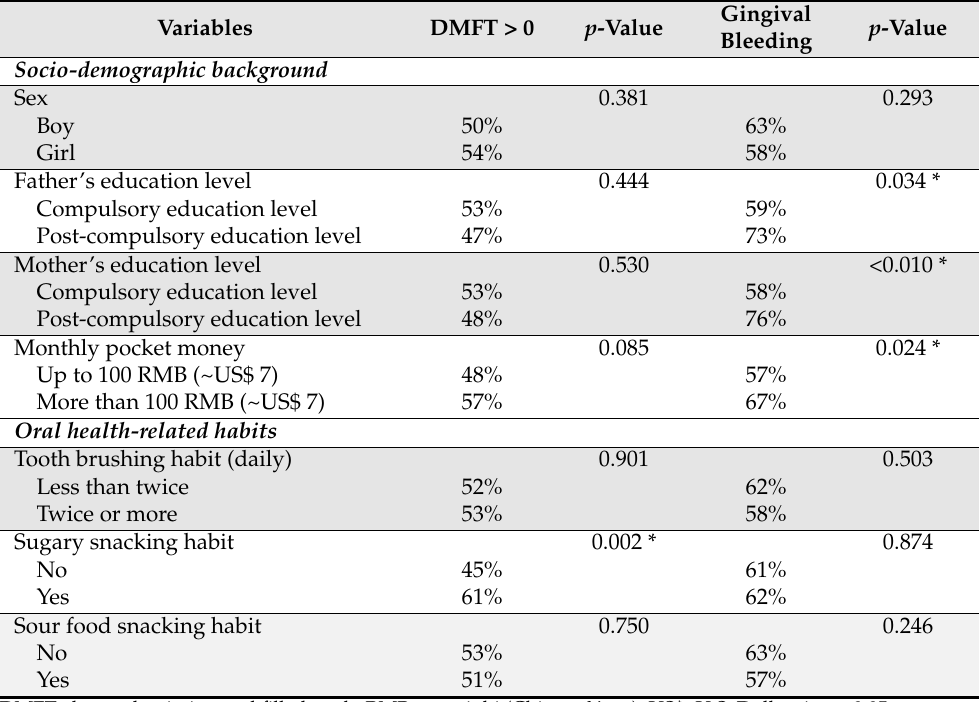
Table 2. Prevalence of dental caries and gingival bleeding according to sociodemographic background and oral health–related habits (N = 413).